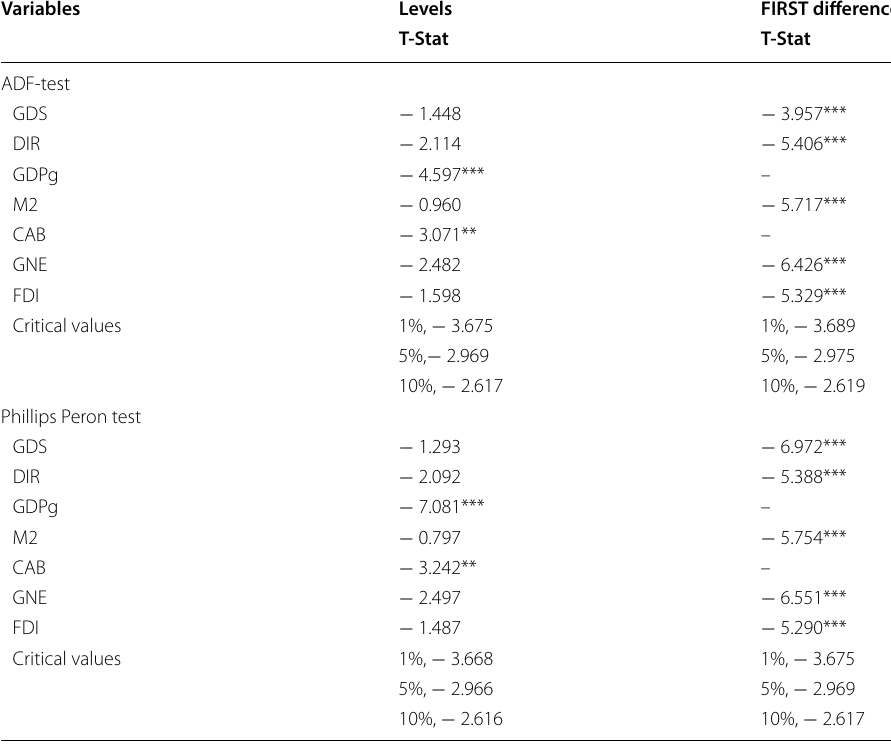
Table 2 ADF and PP unit root tests for stationarity: levels and first difference. Source: Author’s computation from World Development Indicators database for 2018